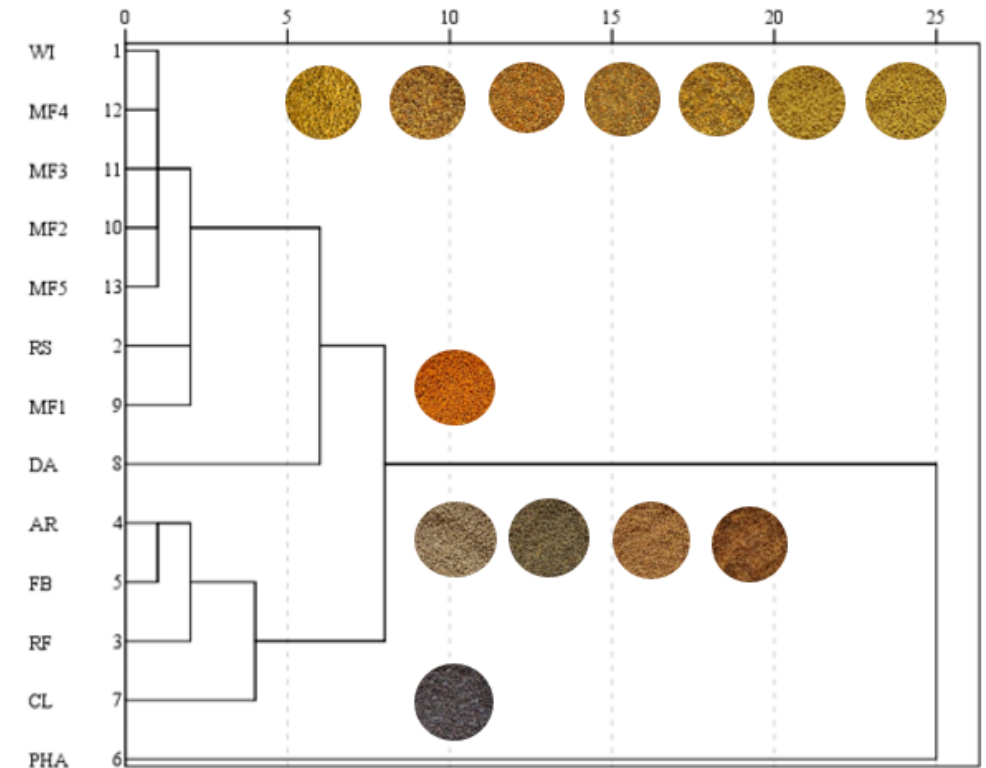
Figure 1. Dendrogram showing average linkage between groups of honey bee-collected pollen based on its colour: plants of origin for monofloral pollen: AR—autumn raspberry, CL—clover; DA—dandelion; FB—fava beans; PHA—phacelia; RF—rye flower; RS—rapeseed; WI—willow; plants of origin for multifloral pollen: MF1—Broceni; MF2—Bene; MF3—Tervete; MF4—Saldus; MF5—Kuldiga.